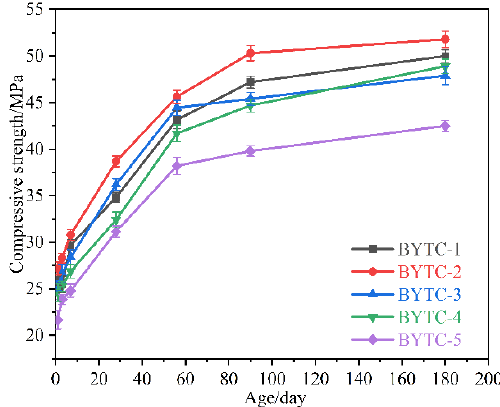
Figure 12. Compressive strength of BYT cement, prepared at w / c = 0.5.